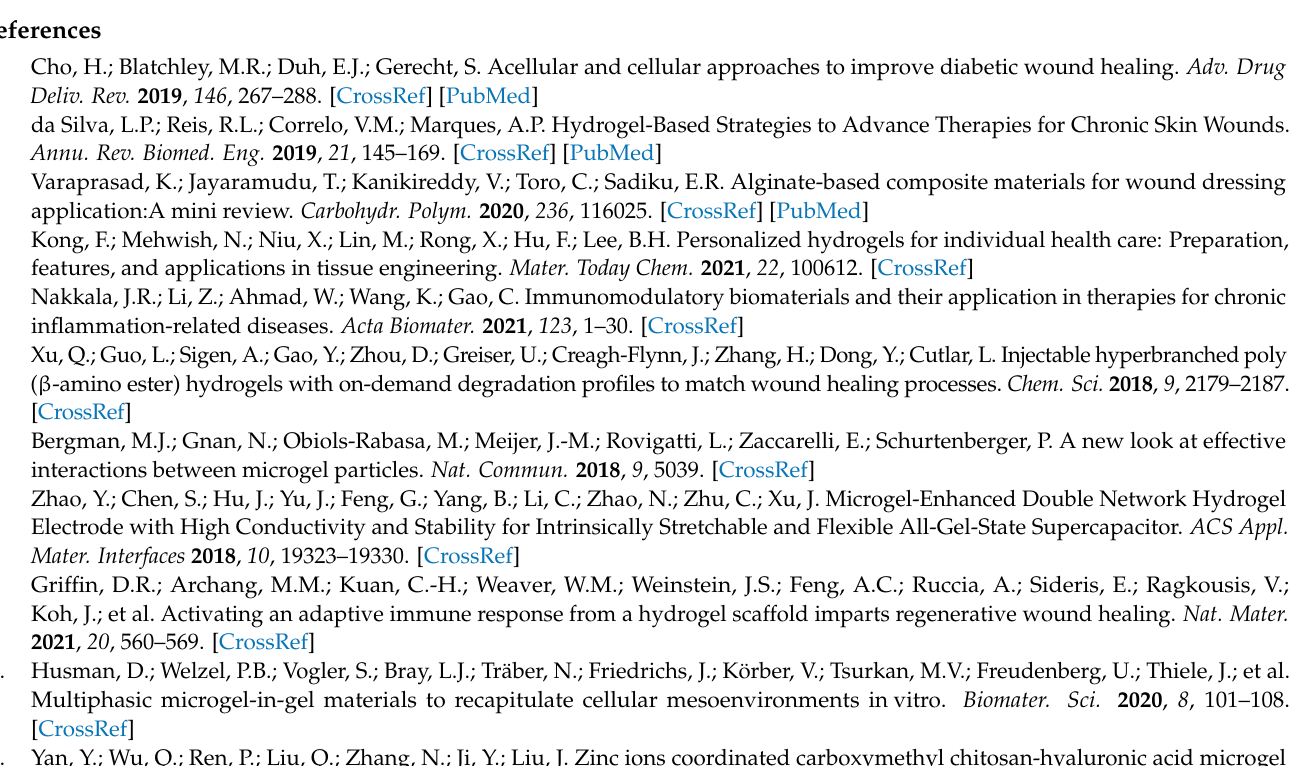
Table S1 The relative molecular weight & distribution of the